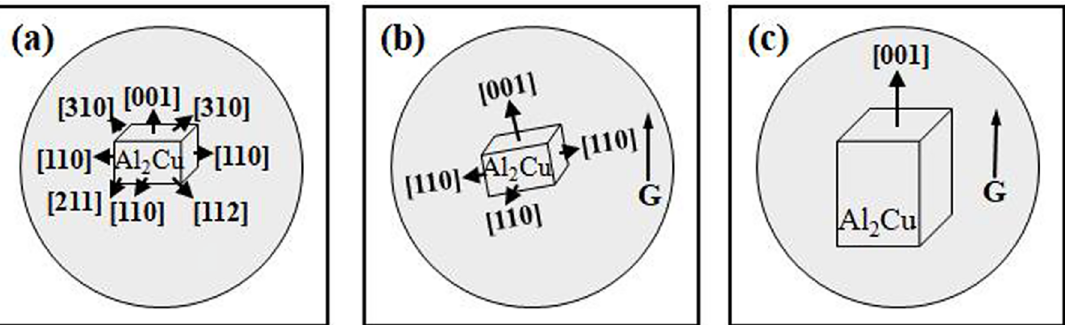
Cu phase crystal: (a) under free solidification, (b) in 4 mm sample under directional Figure 7. Growing schematic illustration of Al 2 solidification, and (c) in 0.45 mm sample under directional solidification.